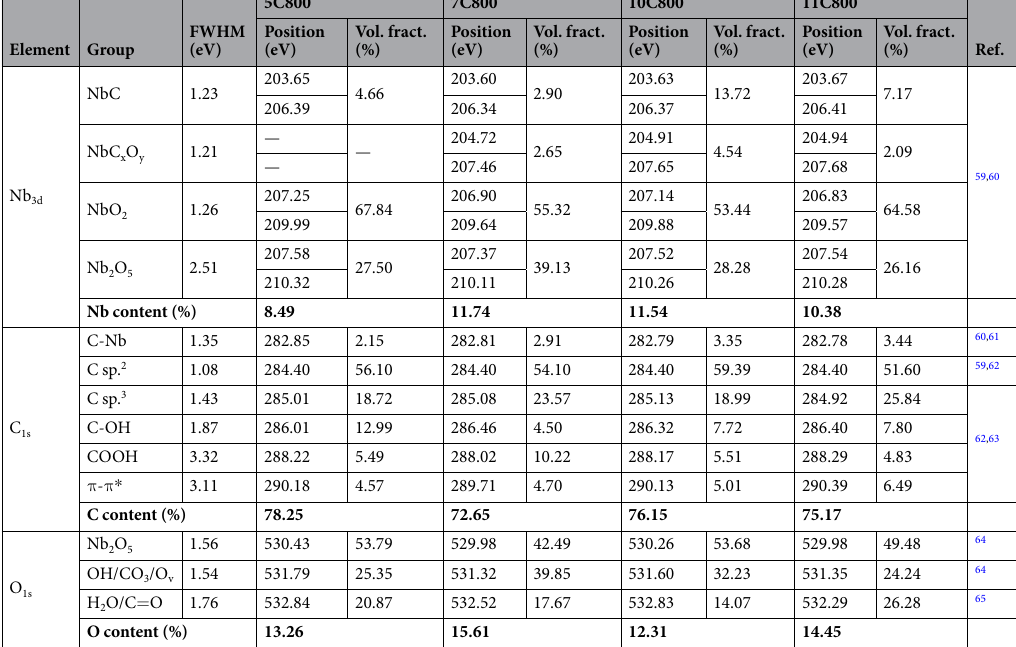
Table 3. Position and area under the de-convoluted peaks of different elements observed in high resolution XPS spectra of 5C800, 7C800, 10C800 and